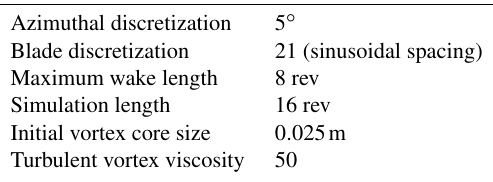
Table 3. Main parameters of the QBlade simulations.